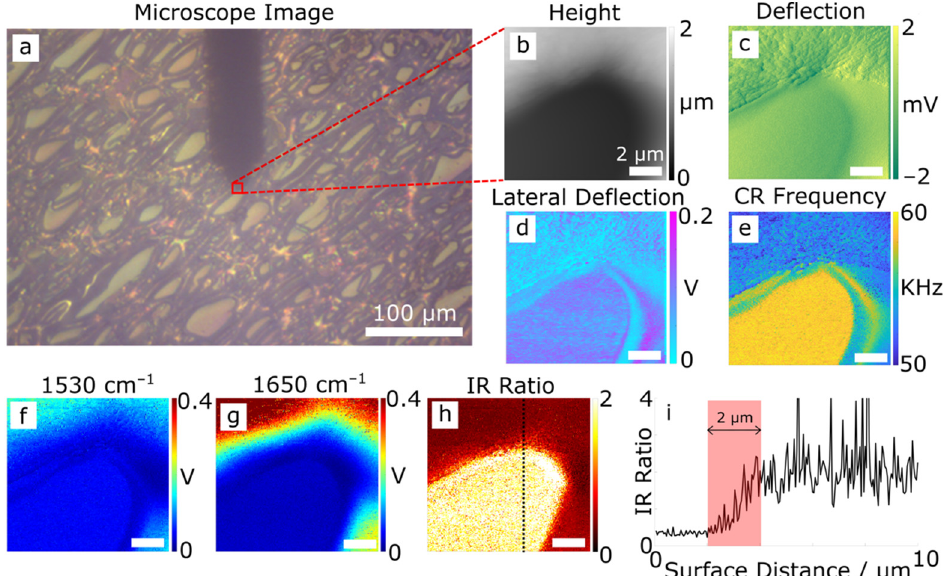
Figure 1. AFM-IR analysis of a microtomed section of PPB showing ( a ) an optical microscope image of the surface (including the AFM cantilever silhouette), as well as 10 × 10 μ m maps of ( b ) height, ( c ) (vertical) deflection, ( d ) lateral deflection (friction), ( e ) contact resonance (CR) frequency, and IR intensity maps at ( f ) 1530 and ( g ) 1650 cm − 1 . A map of the ratio of the intensity at 1530 to that at 1650 cm − 1 is shown in ( h ) and a corresponding vertical line profile through the ratio map traversing the domain boundary (dotted line in h) is shown in ( i ).